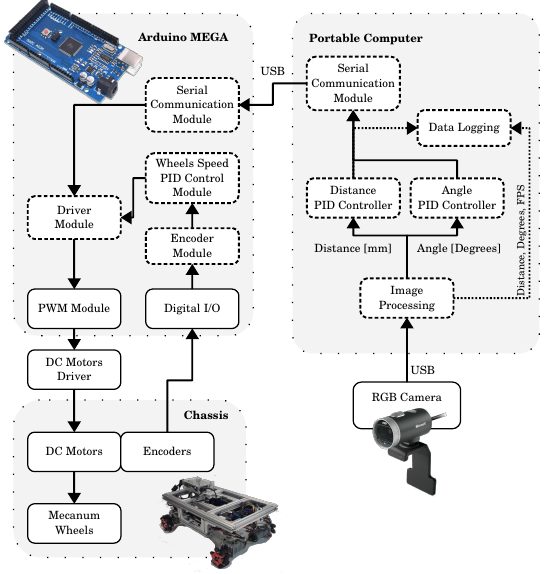
Figure 6. AGV system